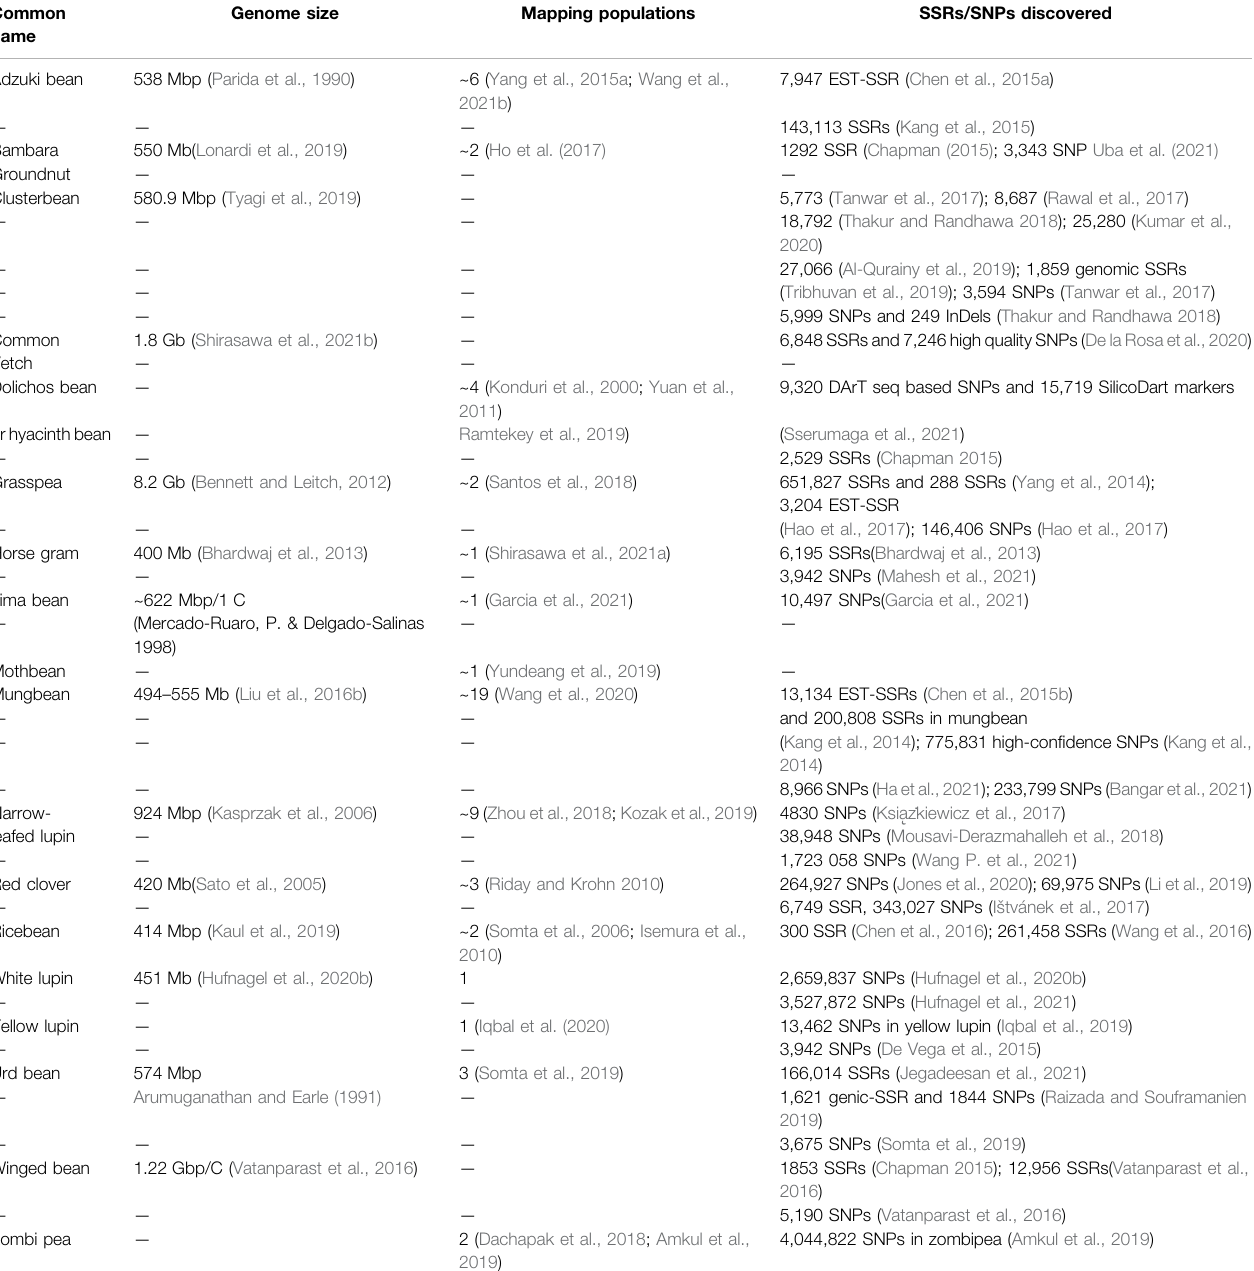
TABLE 1 | Genomic resources in underutilized legumes developed during the last